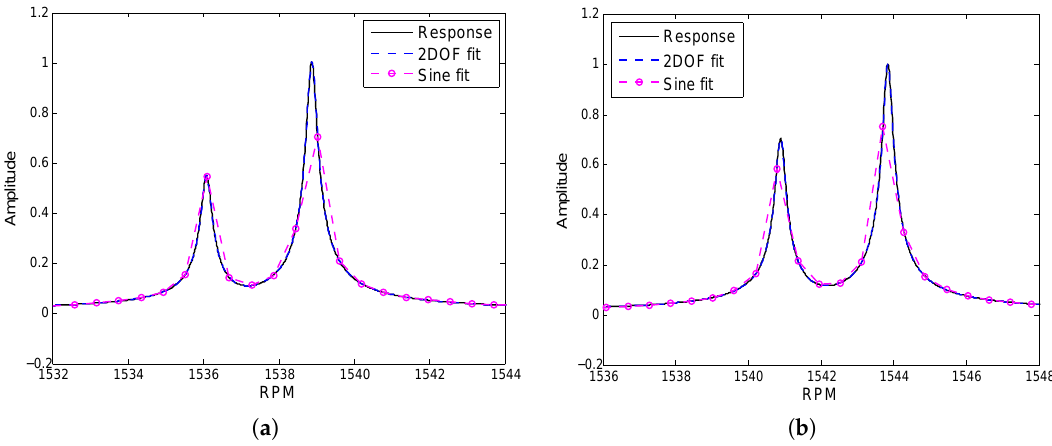
Figure 10. Comparison of non-dimensional amplitudes obtained by different fitting methods for EO = 10 and ζ 1,2 = 0.0001, ( a ) SD = 0.05, ( b ) SD =